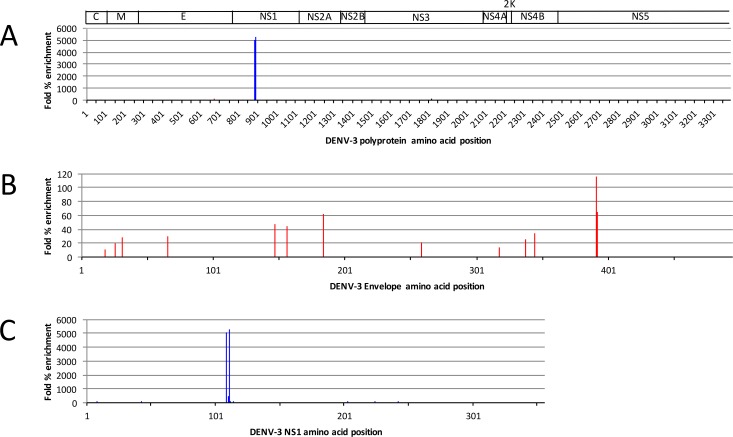
Deep sequencing results from two rounds of deep sequence-coupled iterative biopanning with serum sample 1536.(A) Fold % enrichment of each peptide is presented for the entire DENV-3 polyprotein. (B and C) E and NS1 protein regions are shown enlarged from (A). Note the change in y-axis scale.